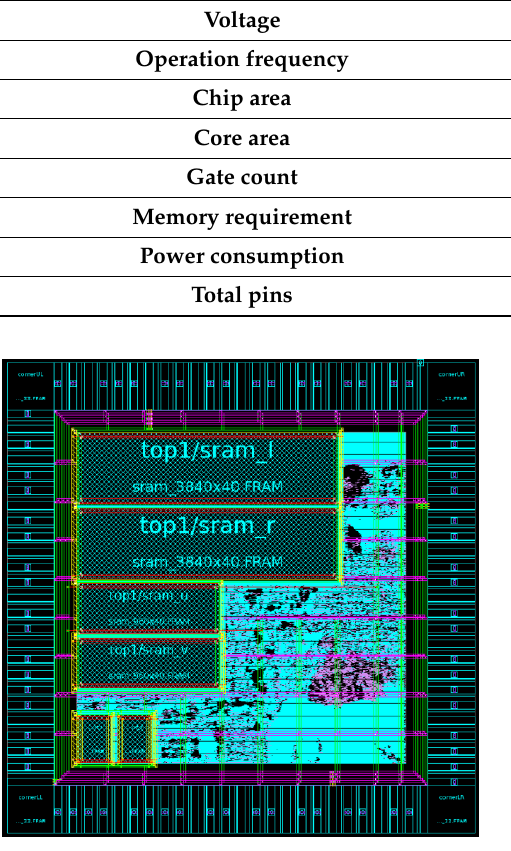
Figure 11. ASIC layout.